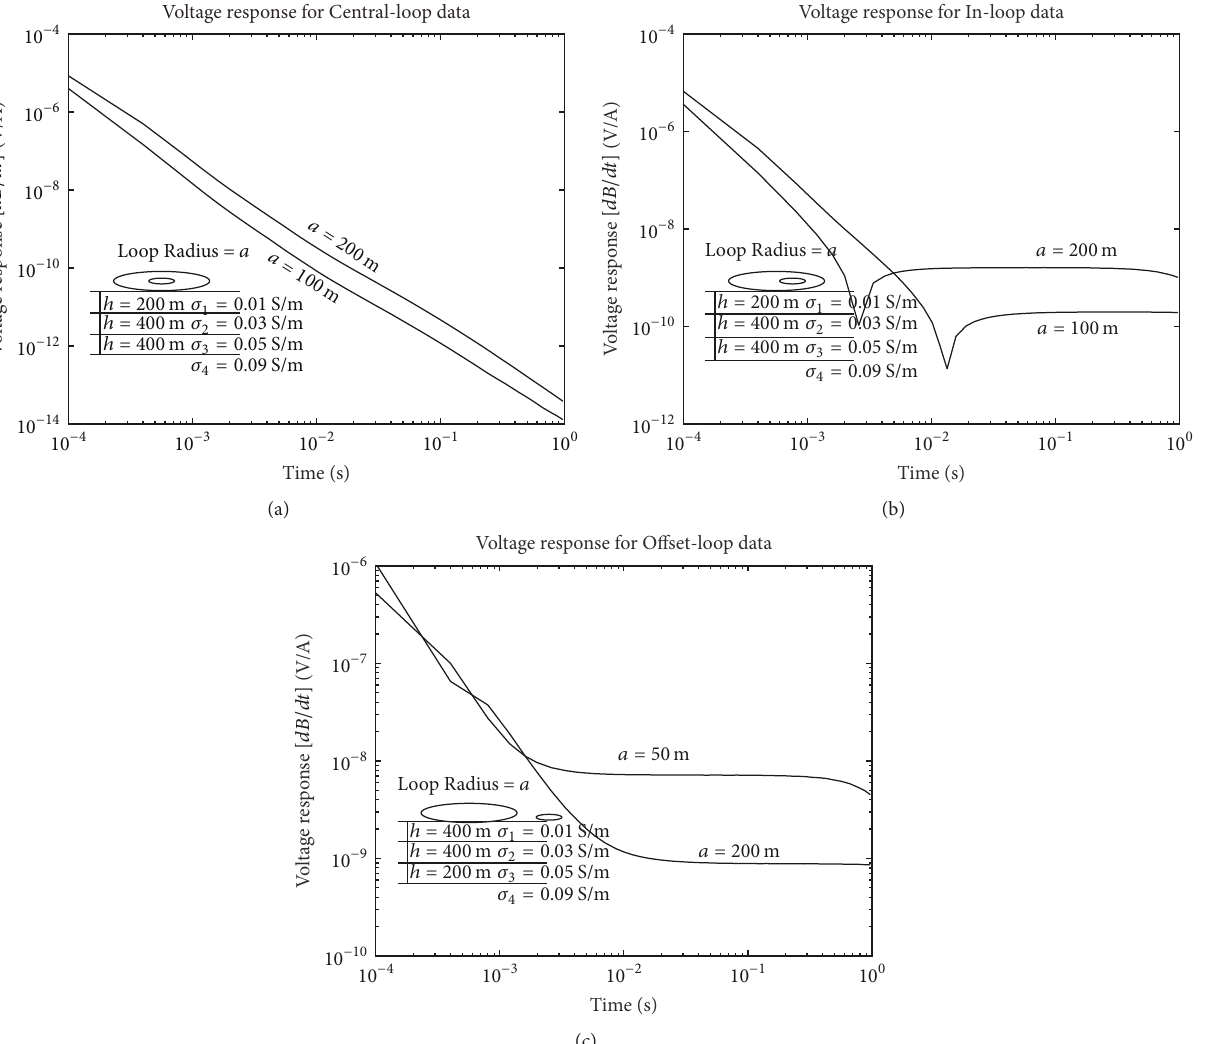
Figure 5: Transient voltage response of large circular loop source of radii 100 m and 200 m over the 4-layer earth model (as shown in the inset of the figure) for (a) central loop configuration, 𝑟 = 0 , (b) arbitrary in-loop configuration, 𝑟 = 𝑎/2 , and (c) arbitrary offset-loop configuration, 𝑟 = 2𝑎